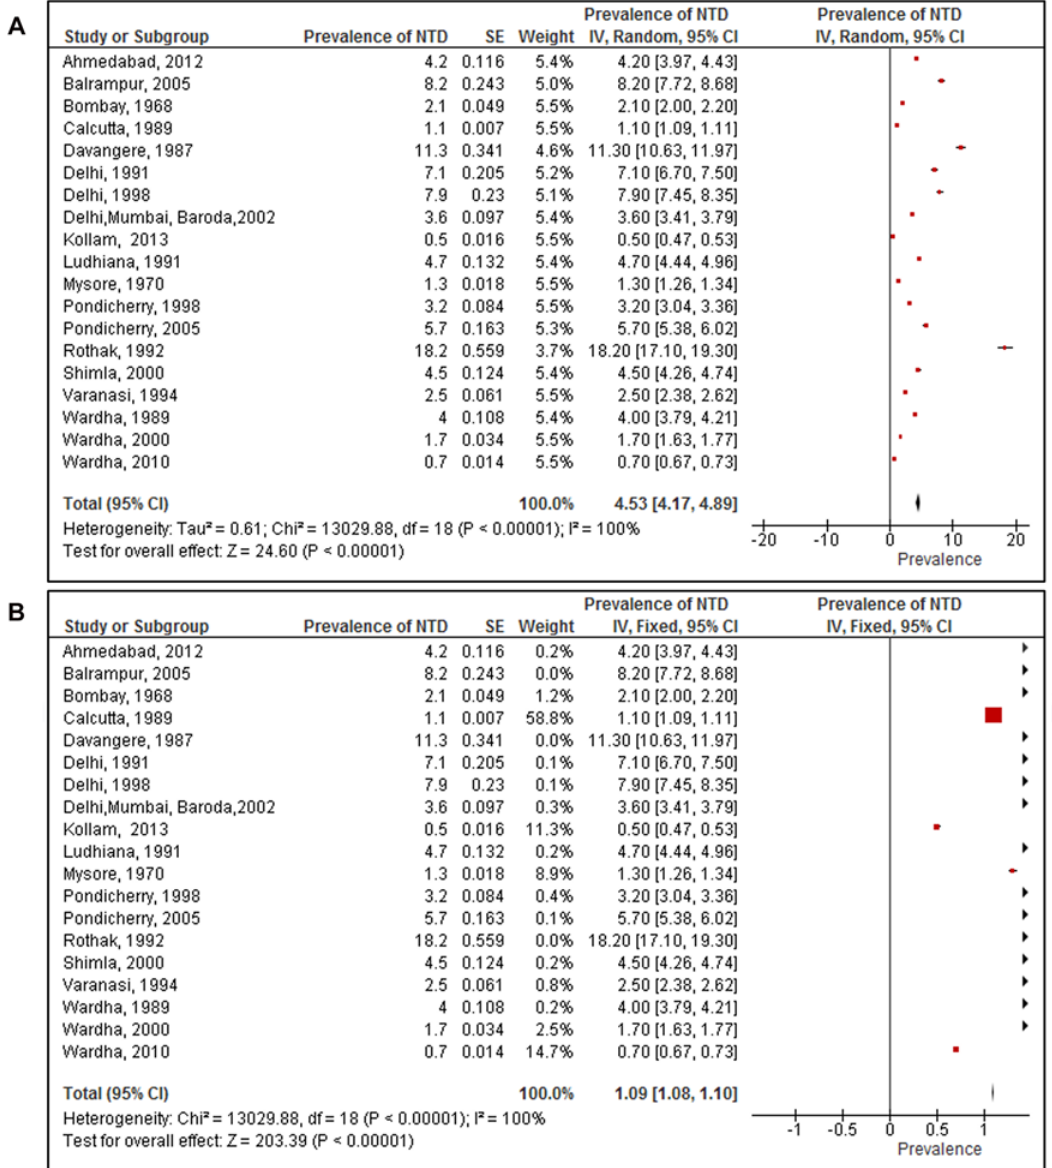
Fig 2. Prevalence of neural tube defects among studies included in the systematic review and meta-analysis. (A) Pooled prevalence of neural tube defects using the random effects model. (B) Pooled prevalence of neural tube defects using fixed effects model.